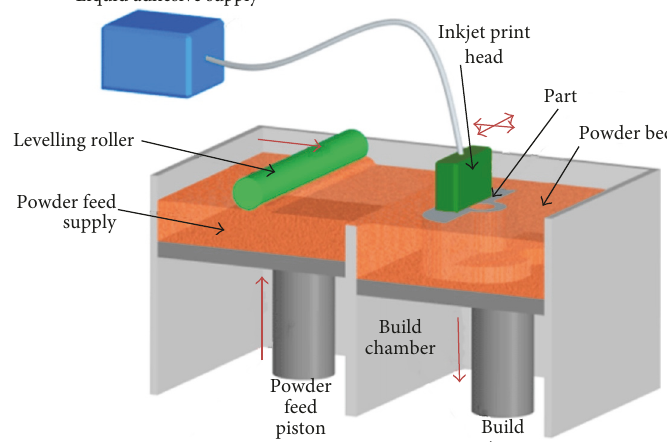
Figure 1: Indirect Inject Print (IIP) is a layer-by-layer process of depositing liquid binder onto thin layers of powder to create a 3D object